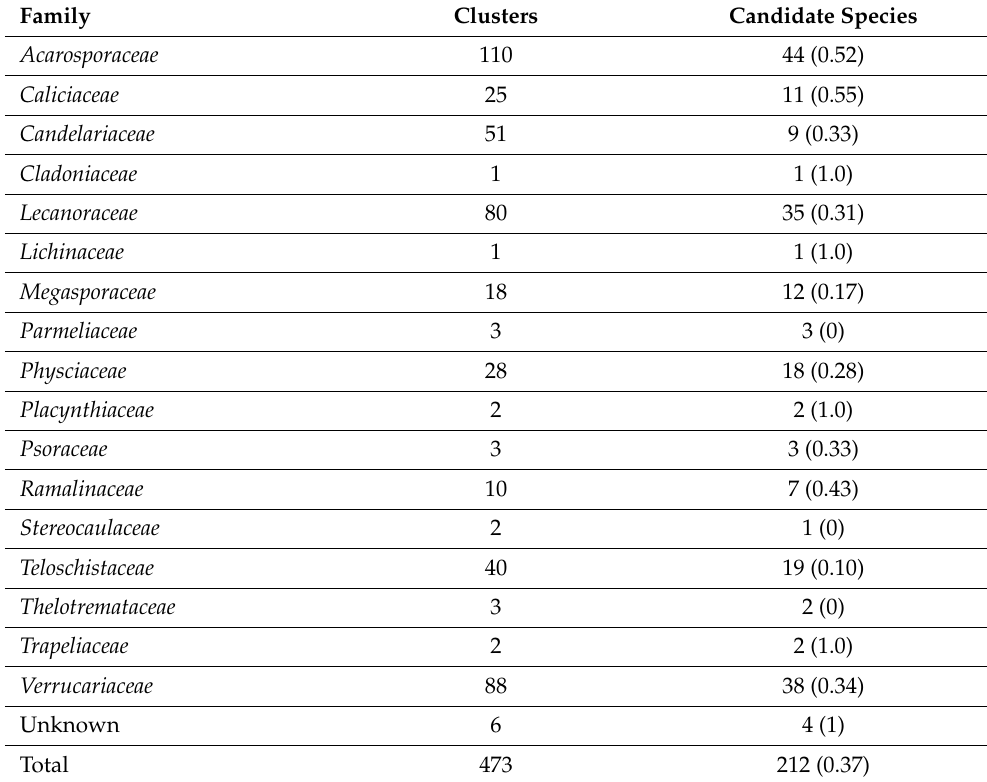
Table 2. Taxonomic distribution of genetic clusters and candidate species that were recovered at Buckhorn Wash, Emery County, UT, USA. The proportion of candidate species that was sampled in Buckhorn Wash but was not represented in the BOLD regional DNA reference library (BOLD project LIMW) is reported parenthetically next to the total number of candidate species in each family.